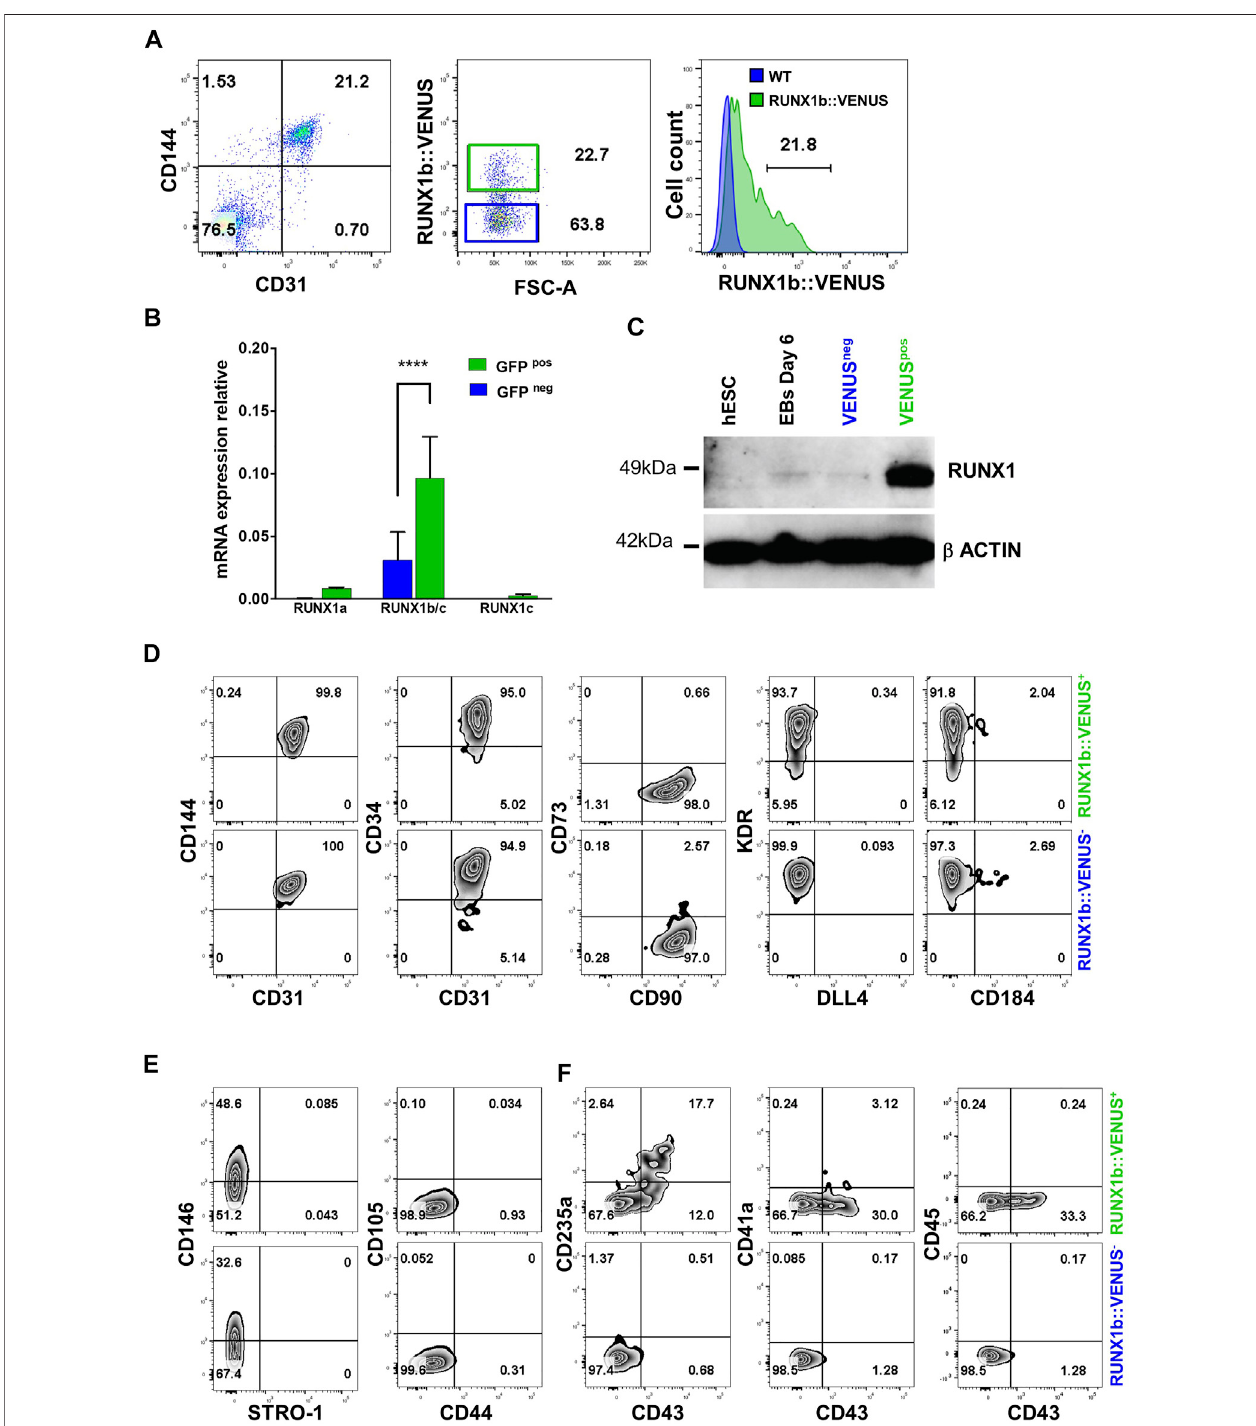
FIGURE 2 | Characterization of the RUNX1b:VENUS population. (A) Flow cytometry analysis of CD144 and CD31 expression in day 6 EBs (left panel) . RUNX1b: VENUS expression level in the CD144 + CD31 + population (middle panel) . RUNX1b:VENUS expression against control auto- fl uorescence from CD144 + CD31 + differentiated wild-type hESCs (right panel) . (B) Expression of the indicated genes by qRT-PCR in VENUS positive and negative CD31 + CD144 + cell populations sorted from day 6 EBs. Data are presented as mean +/ − SD of 3 independent experiments. (C) Western blot analysis for RUNX1 protein level in the indicated populations. β − ACTIN expression wasused as loading control. (D – F) Flow cytometry analysis ofVENUS positiveand negative cell populations at day 6of differentiation for the indicated cell surface markers. All data are representative of at least 3 independent experiments.